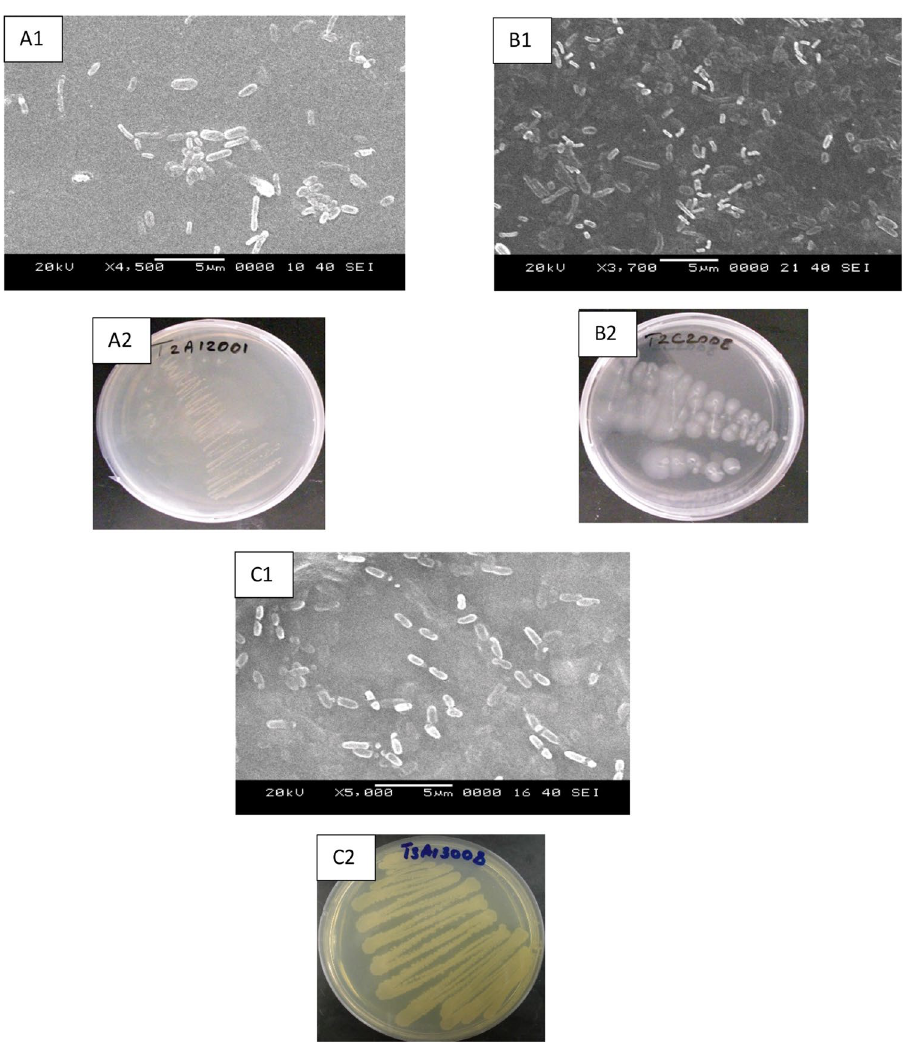
Figure 1. SEM images and photographs of bacteria on nutrient agar plates of P. mirabilis ( A1 , A2 ), B. brevis ( B1 , B2 ) and R. quinshengi ( C1 , C2